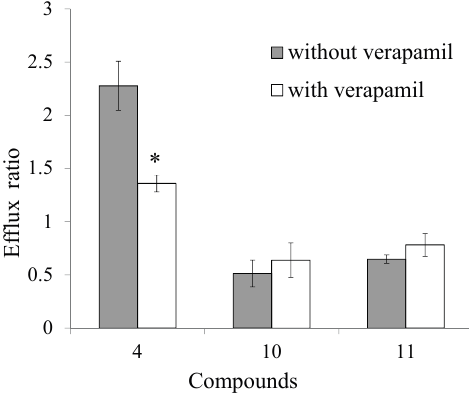
Figure 5. The efflux ratios of coumarins 4 , 10 , 11 in MDCK-pHaMDR cell in the absence or presence of 100 μ M verapamil. * p < 0.01 vs. verapamil absent